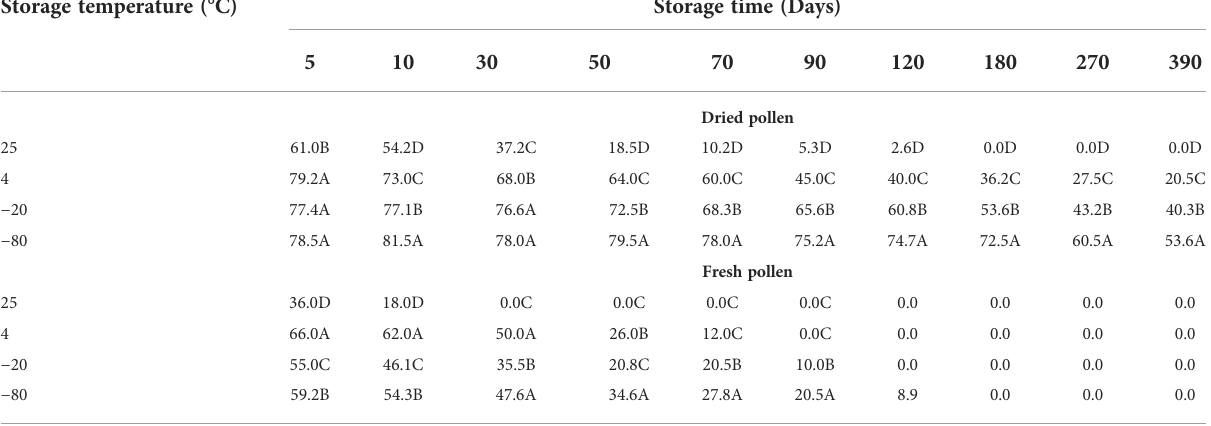
TABLE 5 Effects of storage temperature and storage times on in vitro pollen germination. Storage temperature